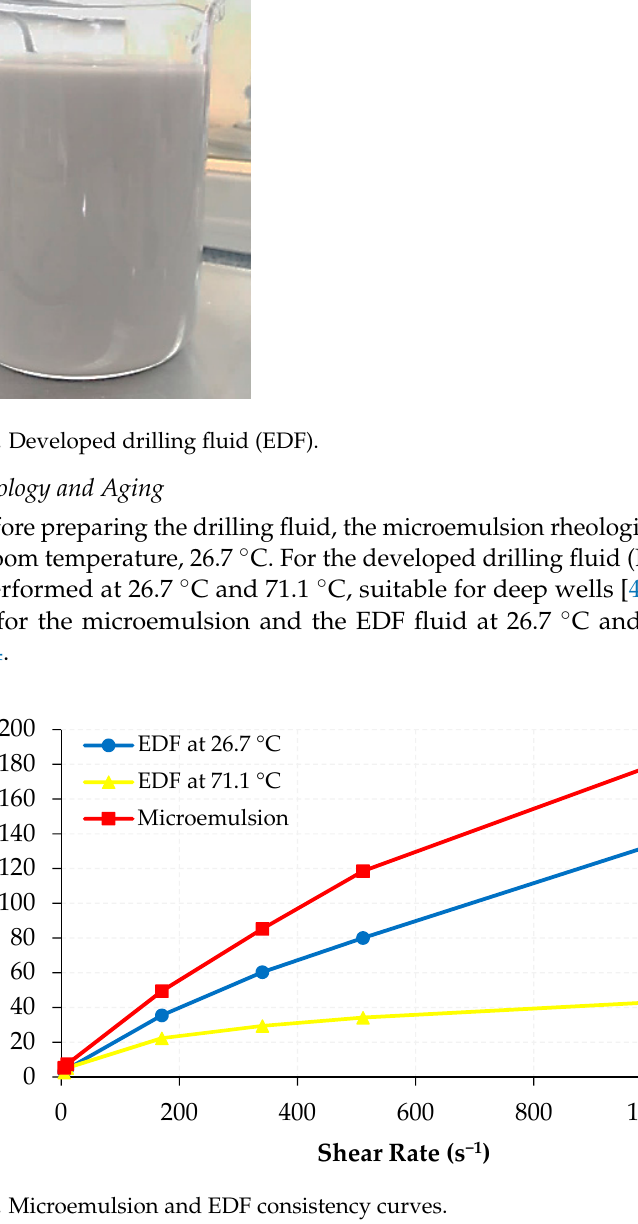
Figure 4. Microemulsion and EDF consistency curves.